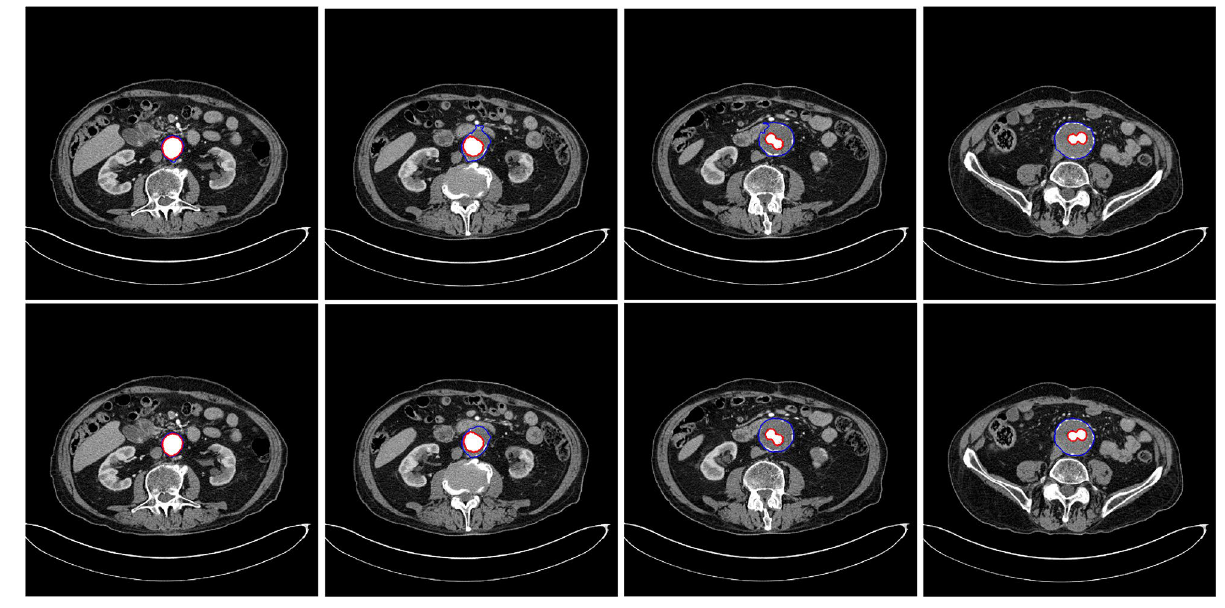
Figure 1. An example of segmentation by the two pipelines, with axial cross-sections of an aneurysm at four different levels. The standard pipeline is shown on the top row, with the hybrid pipeline on the bottom row. Here the standard pipeline is unable to accurately follow the contour of the aneurysm. The hybrid pipeline appears accurate.